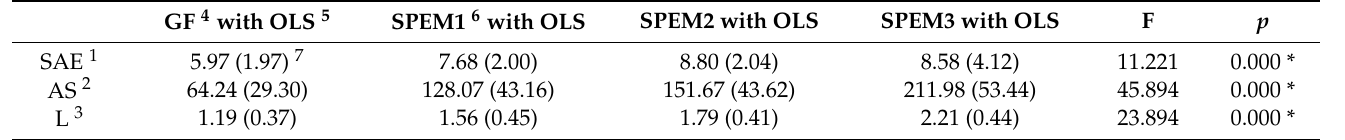
Table 2. Comparison of the four exercises on the center of pressure (surface area ellipse, length, and average speed).